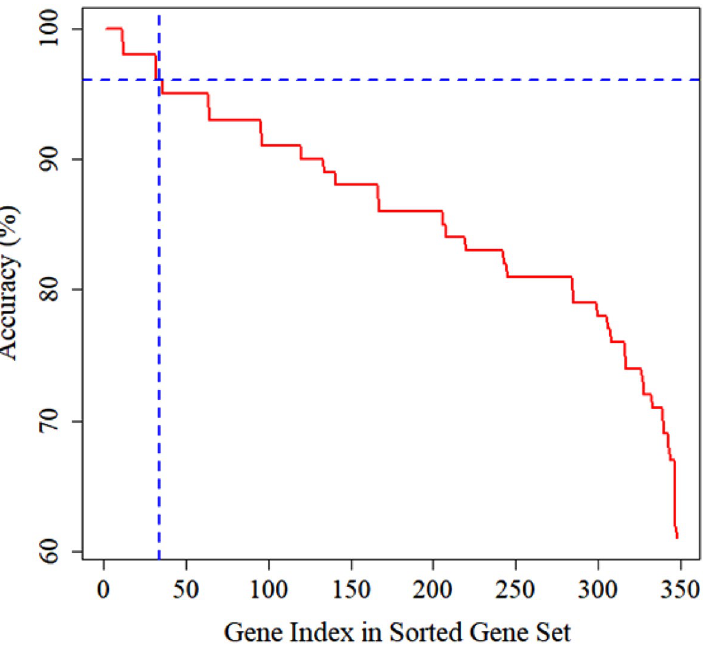
Figure 4. Classification accuracy of SVM for each